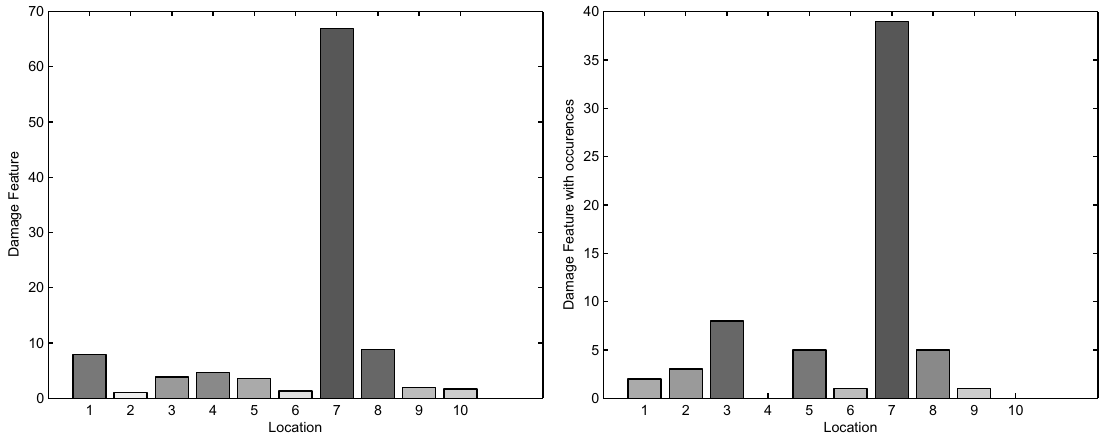
Fig. 35. Damage feature without and with occurrences for damaged structure and changing loading conditions, frequency range 10–15Hz.